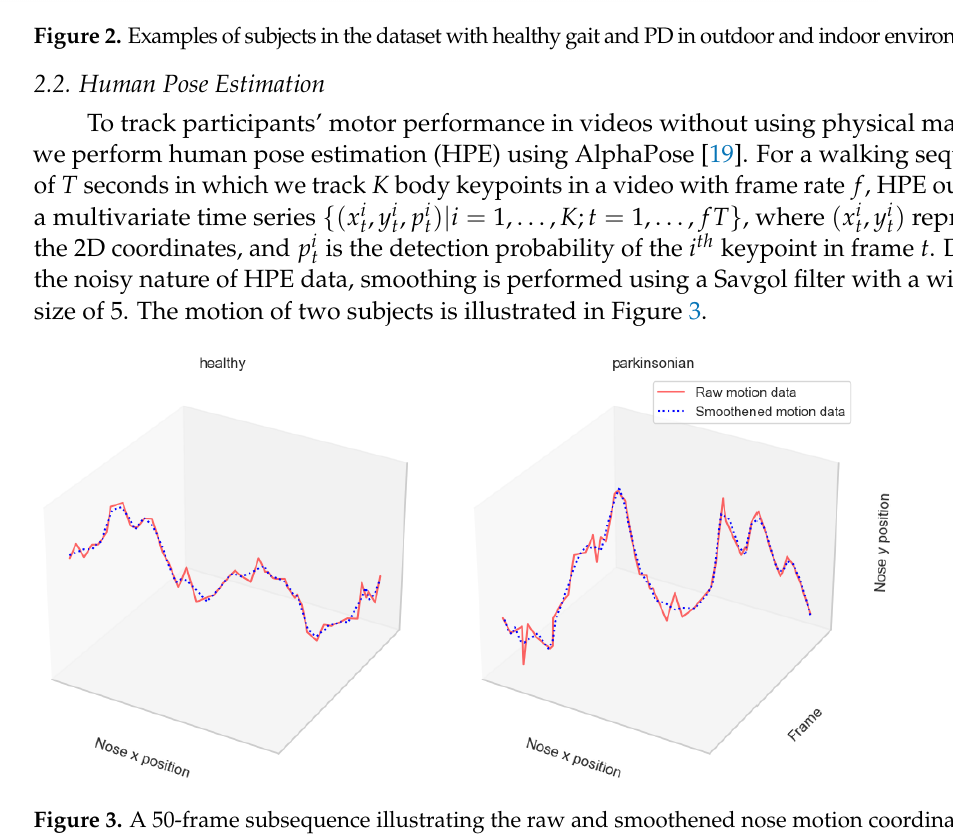
Figure 3. A 50-frame subsequence illustrating the raw and smoothened nose motion coordinates for a healthy and a Parkinsonian gait sequence. Nose X and Nose Y refer to the coordinates of the nose in the 2D